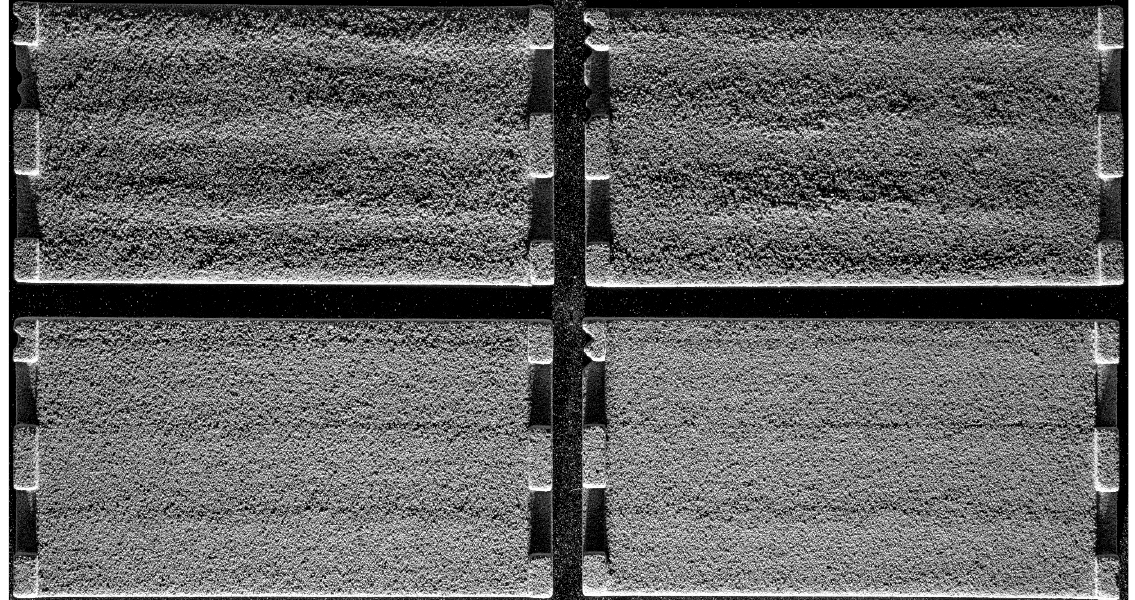
Figure 13. Four identical downskin smoothing parts finished by four different people. The upper two samples still contain a surface layer of loosely adhering sand, while the lower two are finished correctly with a higher surface strength remaining.